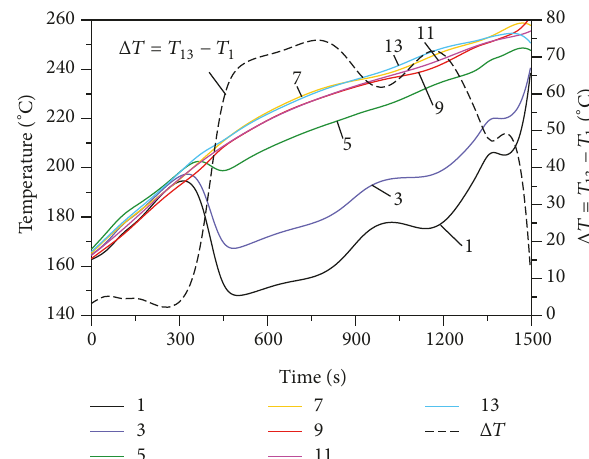
Figure 5: Temperature transients on the outlet header inner surface and the temperature difference transient between the outlet header top and bottom Δ𝑇 = 𝑇 13 − 𝑇 1 .